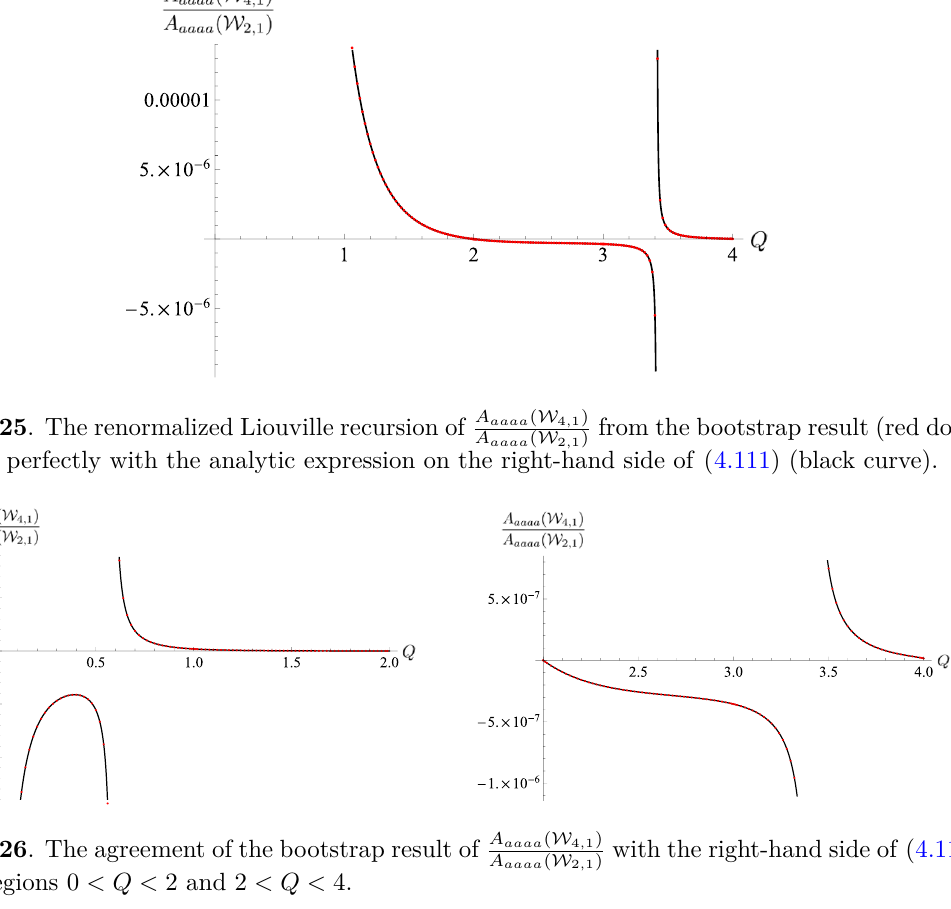
with the right-hand side of (4.111) A aaaa ( W 2 , 1 )